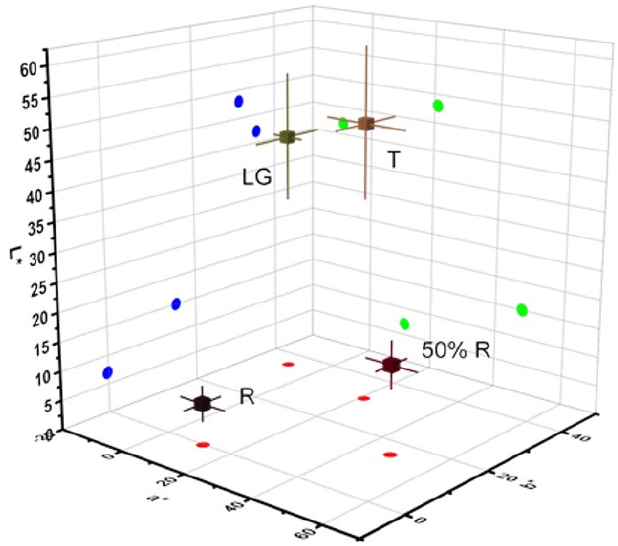
Figure 2. Three-dimensional spectrum of CIELab (L*, a* and b*).